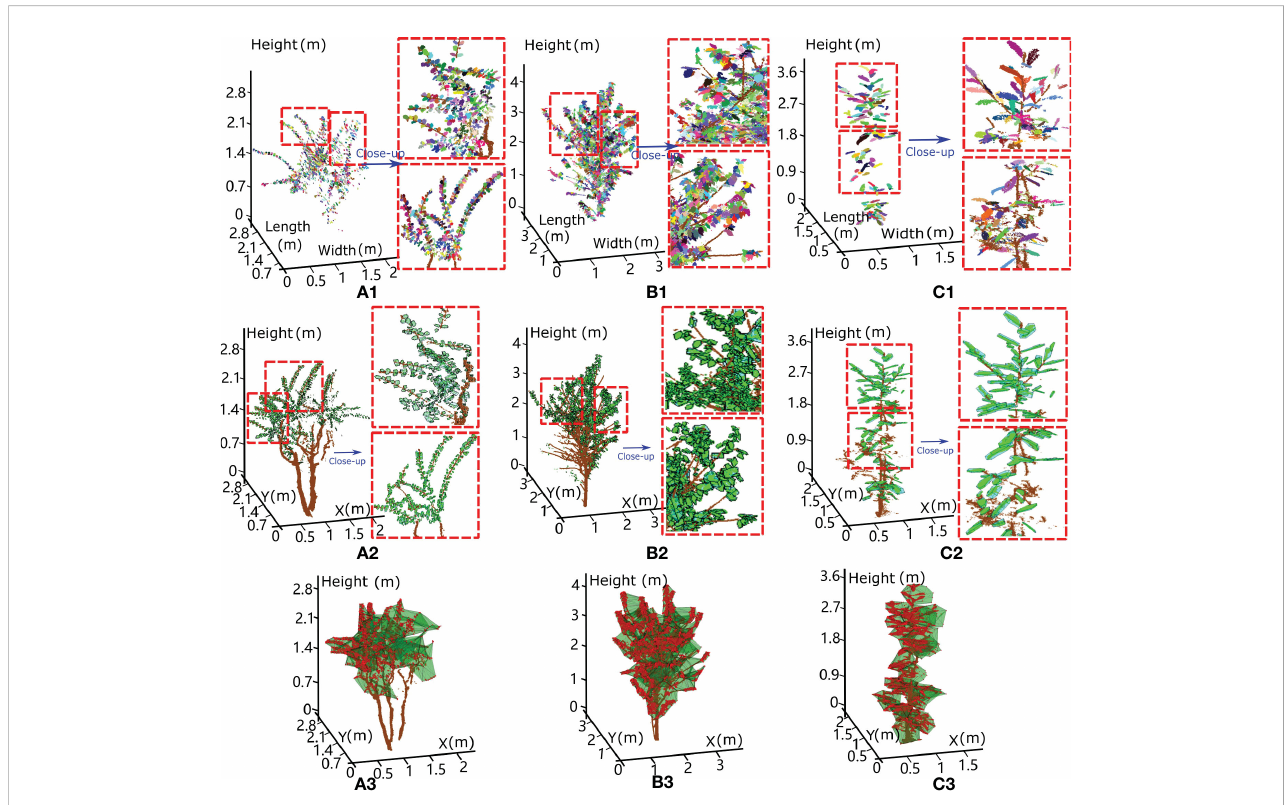
FIGURE 4 The results for three small experimental trees, with each leaf extracted from the scanned points (a1, b1 and c1) and wrapped with a hexagonal prism (a2, b2 and c2). The tree crown enclosure was determined based on the alpha shape algorithm (a3, b3 and c3) and used to assess the volume-based gap fraction of each tree crown with the proposed method. (A) Crepe myrtle tree, (B) sakura tree and (C) magnolia tree, where the results within the red dotted box are magni fi ed to illustrate the validity of our